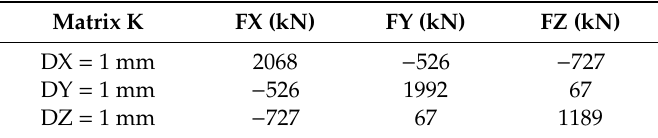
Table 7. Reactions in support after imposed displacements.